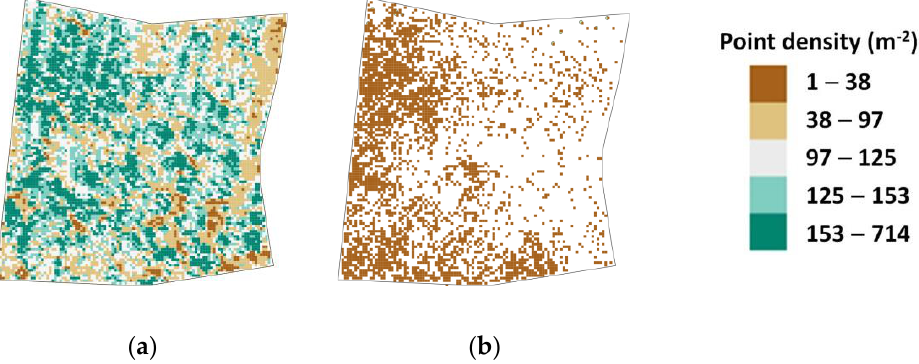
Figure 8. Topographic and LAS surveys: ( a ) first return density of the merged scan lines; ( b ) third return density of the merged scan lines.